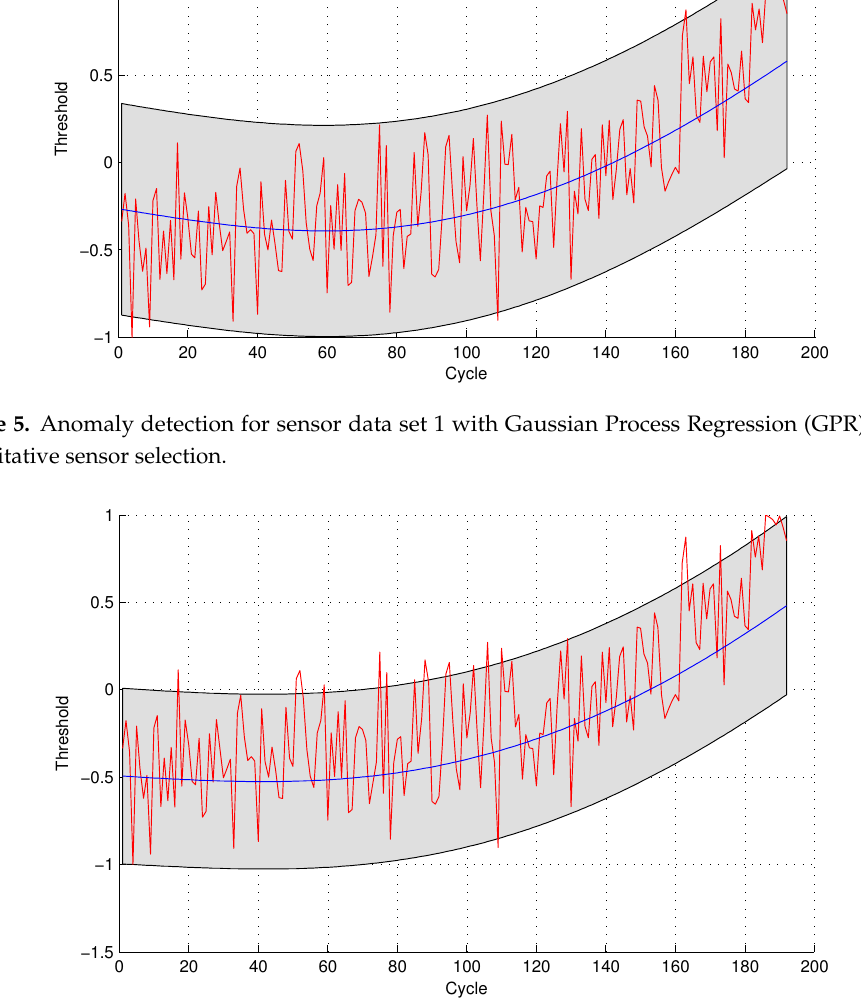
Figure 6. Anomaly detection for sensor data set 1 with GPR for the observing sensor